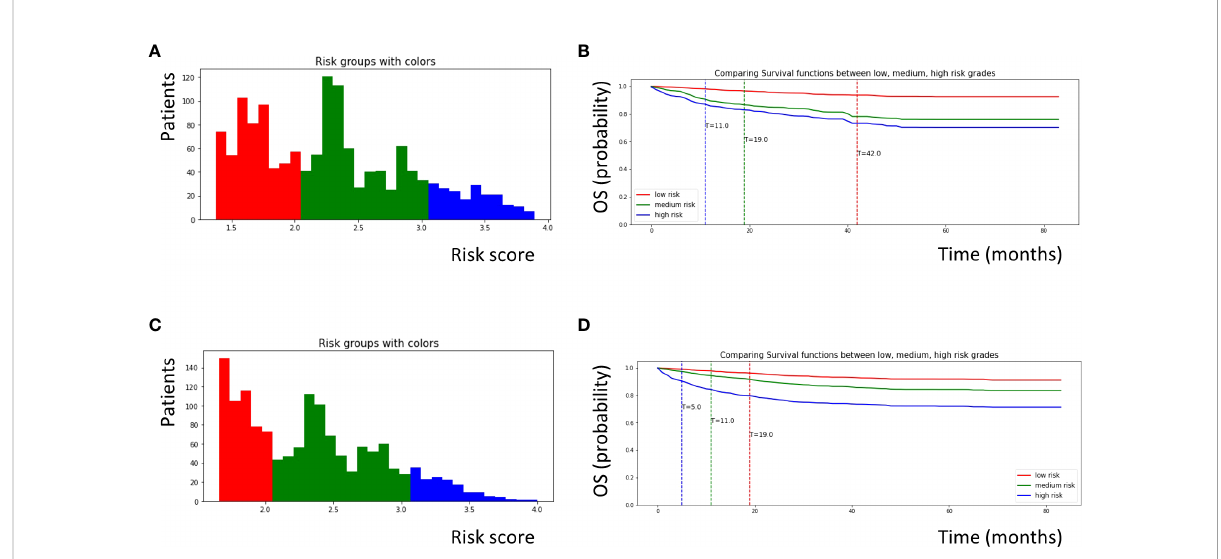
FIGURE 2 Survival curves for patients with OPSCC classi fi ed according to risk scores calculated by each machine learning model. (A) Patients with OPSCC were classi fi ed into low, medium, and high risk groups according to risk scores calculated by the EST model. Patients with a score of 0 – 2.0 were de fi ned as low risk (red color), patients with a score of 2.0 – 3.0 were de fi ned as medium risk (green color), and patients with a score of 3.0 – 4.0 were de fi ned as high risk (blue color). (B) Survival curves for three patients who was randomly selected from each group obtained from the EST model. (C) Similarly, patients with OPSCC were classi fi ed into three groups according to risk scores calculated by the CSF model. Patients with a score of 0 – 2.0 were de fi ned as low risk (red color), patients with a score of 2.0 – 3.0 were de fi ned as medium risk (green color), and patients with a score of 3.0-4.0 were de fi ned as high risk (blue color). (D) Survival curves for three patients randomly selected from each group obtained from the CSF model. OPSCC, oropharyngeal squamous cell carcinoma; EST, Extremely randomized survival tree; CSF, Conditional survival forest.